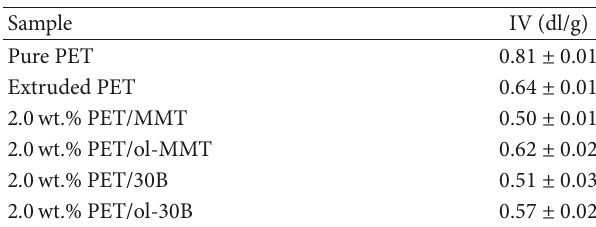
Table 2: IV values of PET and